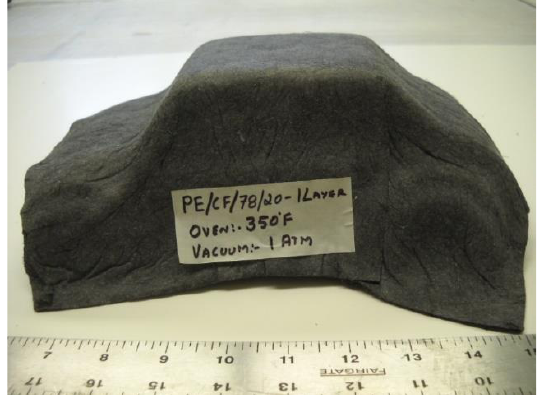
Figure 11. Forming via SDF exhibited optimal draw and consolidation.